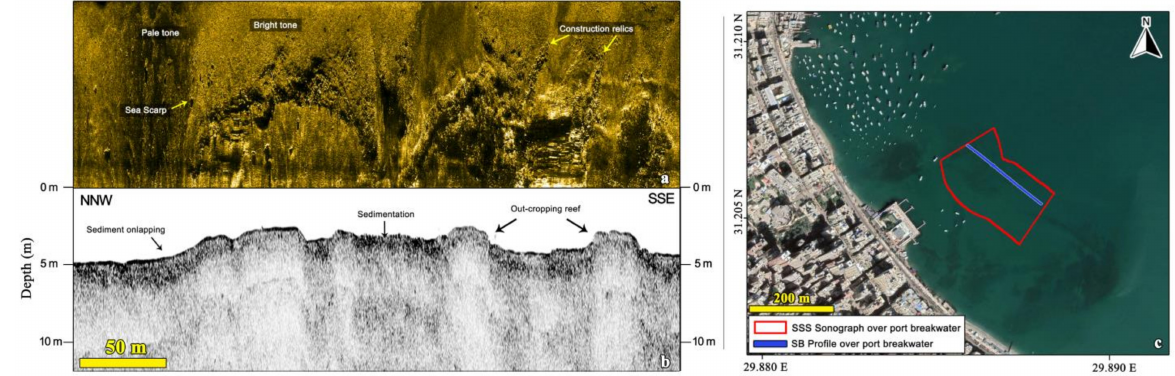
Figure 11. The port side breakwater of the submerged ancient harbor. ( a ) Side scan sonar image; ( b ) Sub-bottom profiler section; ( c ) Location map of the displayed